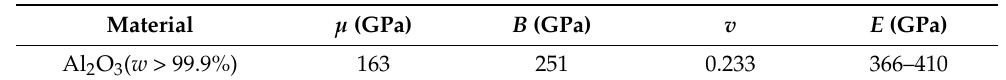
Table 1. Material properties of Al 2 O 3 .